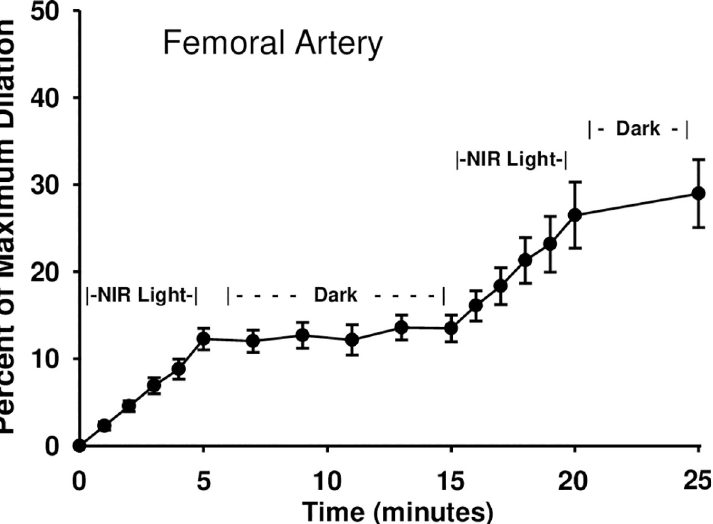
Fig 2. R/NIR vasodilates femoral arteries. Femoral arteries from C57BI/6 mice (n = 8 vessels from 4 mice) were isolated and pressurized to 60mmHg before pre-constriction with U46619. Vessels were exposed to 5 minutes of 670nm NIR Light, 10 minutes in darkness with no light, and then a second exposure of NIR